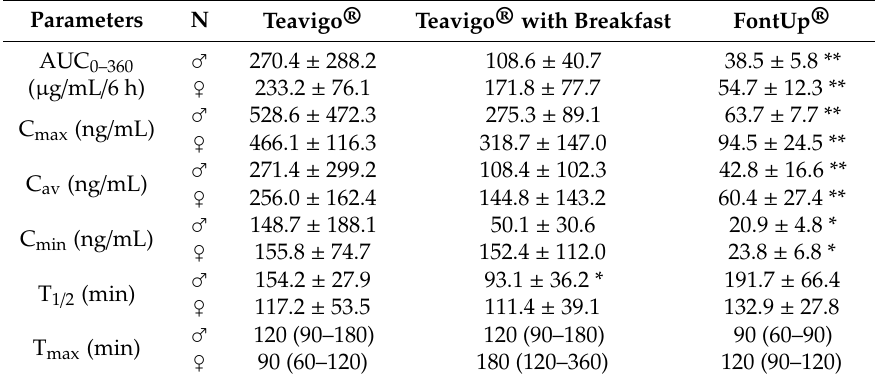
Table A2. Plasma kinetic parameters for EGCG after the three di ff erent series of experiments.